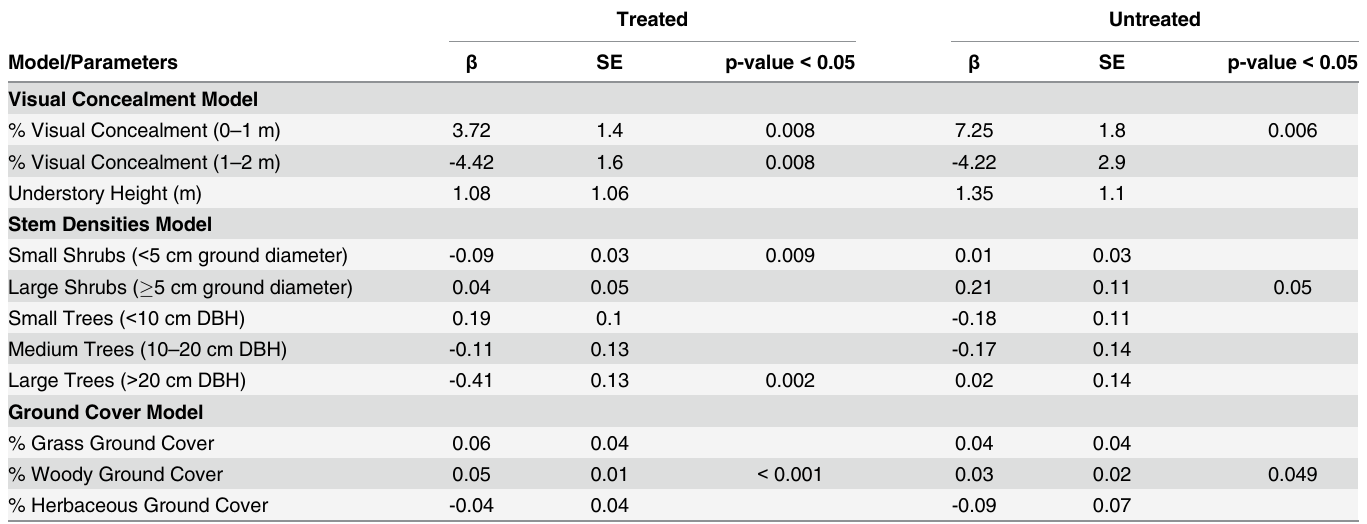
Table 3. Model parameter estimates from five nest habitat models comparing nest-sites and available locations from units treated with early grow- ing season prescribed fire (n(nest,available) = (31,31)) compared to units not treated with early growing season prescribed fire (n(nest,available) = (18,18)). P-values are presented for parameter estimates that were significantly different than zero based on a Wald's t-test. Diameter at Breast Height is denoted by DBH. Only Models with significant parameter estimates are